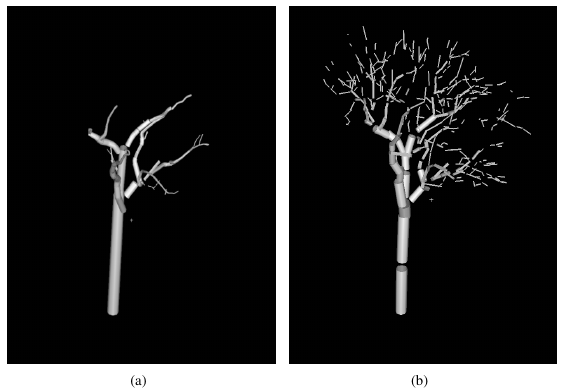
Figure 4: (a) manual cylinder fitting and (b) cylinder fitting by region growing on the